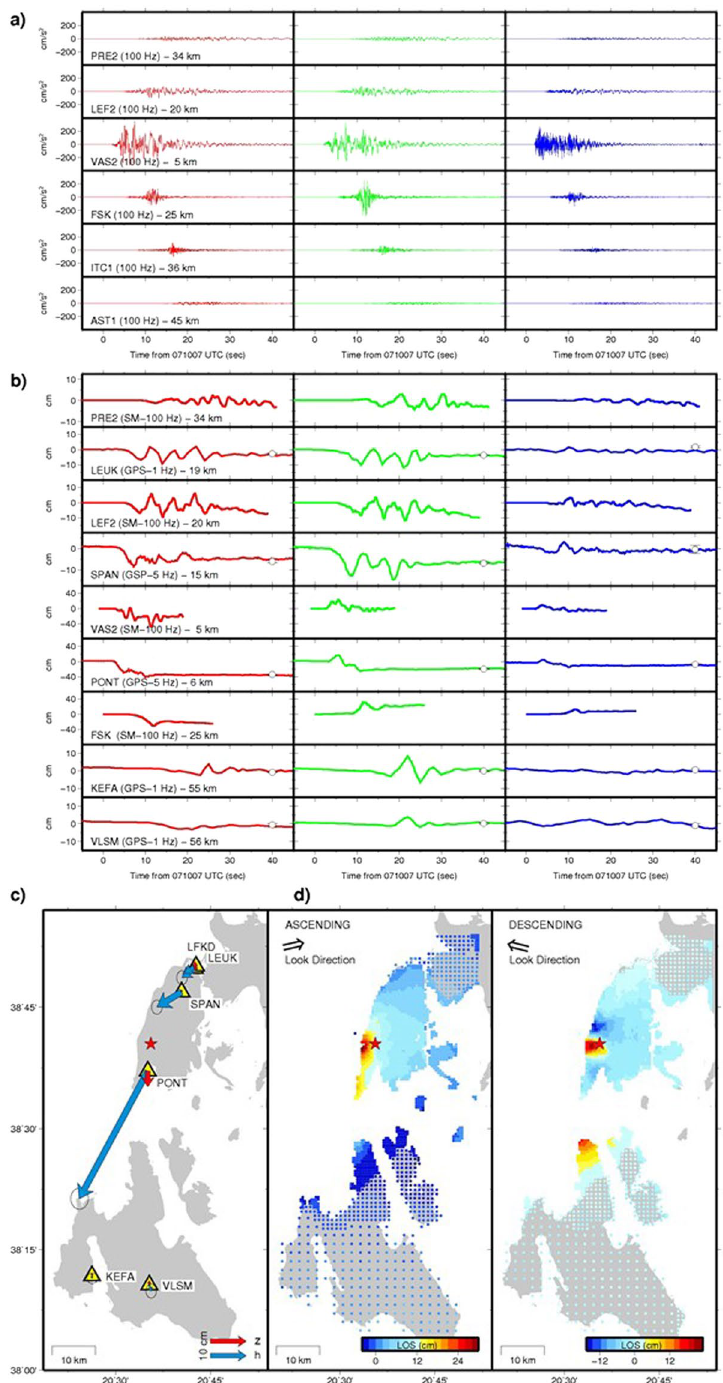
Figure 2. Time histories and static displacements. Time histories of the observed near field accelerations ( a ) and of the high sample rate displacements ( b ) at the available SM and HRGPS sites respectively. The red, green and blue trends represent the North, East and Vertical components, respectively. In the HRGPS time series, the black dashed lines represent the time of the main shock, while the white dots and the vertical bars represent the mean position and their computed 2- σ uncertainties as described in the Supporting Information and in Ganas et al . 2 . The labels in ( a ) and ( b ) indicate the name of the site, the sampling frequency and the distance from the epicentre. ( c ) Horizontal (blue vectors) and vertical (red vectors) static offsets of SM and HRGPS sites located in the studied area. The red star indicates the main shock. ( d ) Sub-sampled ascending (left) and descending (right) Sentinel-1A interferograms. The colour palette represents the amount of displacement in the Lines-Of-Sight (LOS). The plot was created using the GMT (Generic Mapping Tools, http://gmt.soest.hawaii.edu/) software package 57 , version